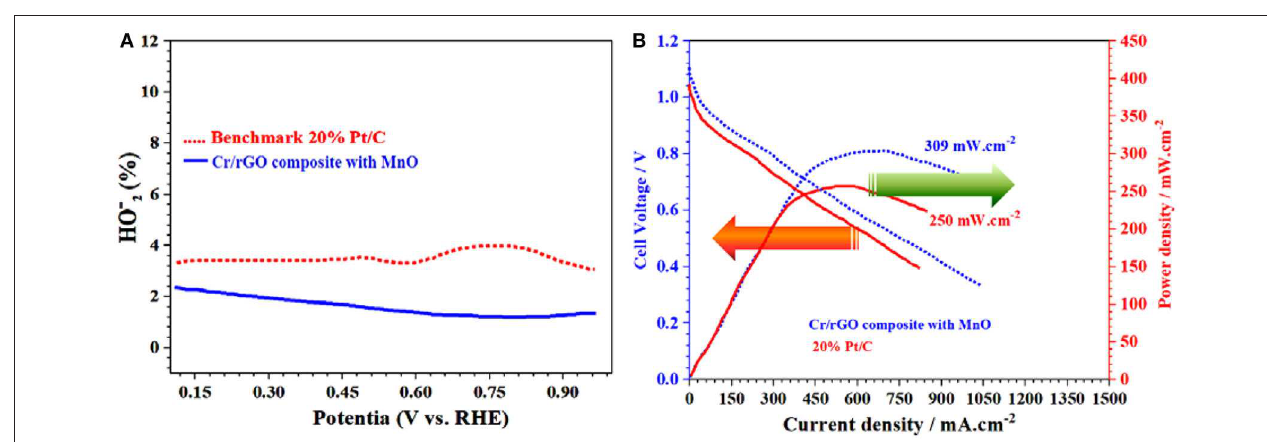
FIGURE 12 | Cr/rGO nanocomposite with MnO. (A) HO − 2 % yield for oxygen reduction reaction. (B) Polarization and power density curves of anion exchange membrane fuel cells. rGO, reduced graphene oxide.